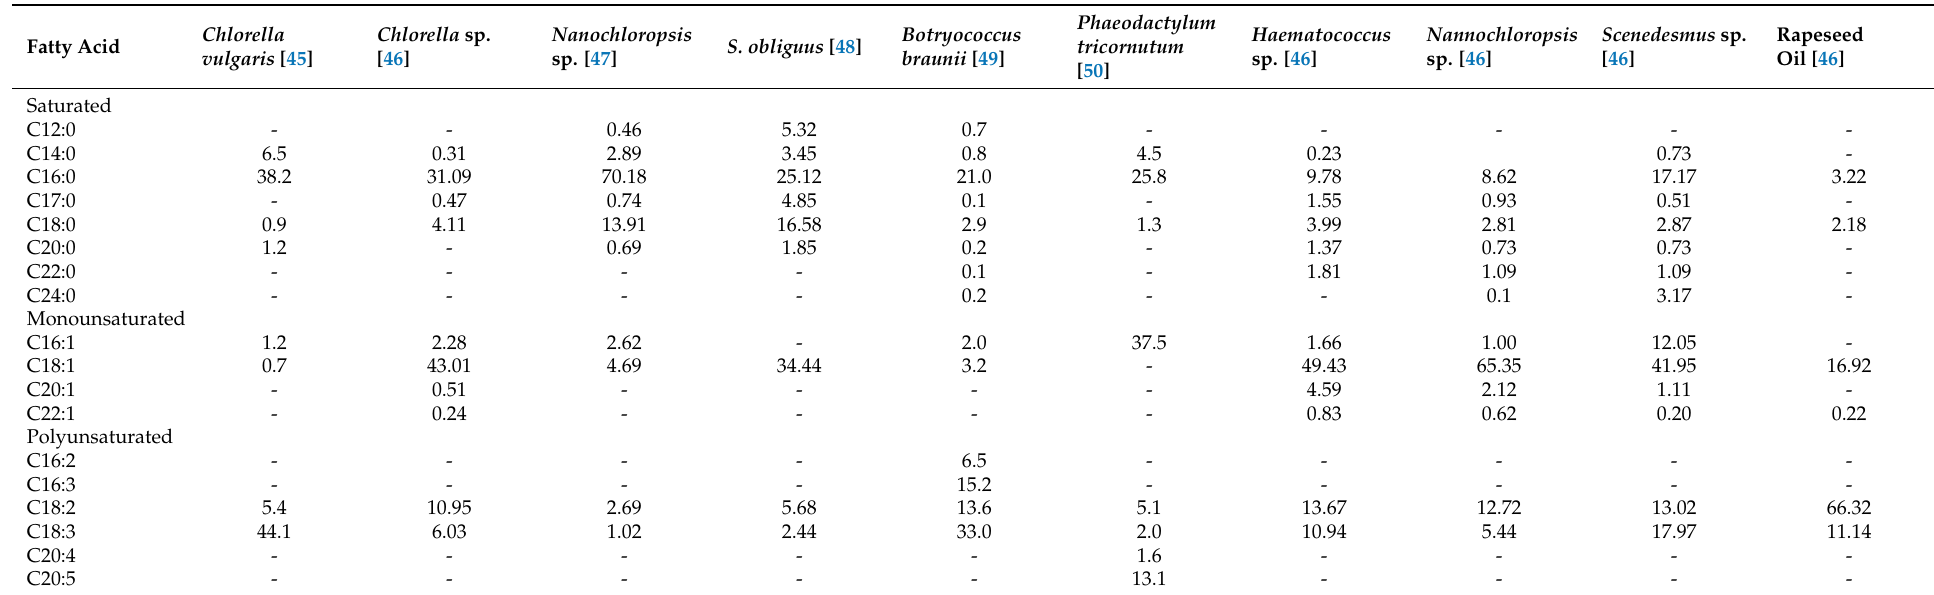
Table 4. Fatty acid composition of microalgae